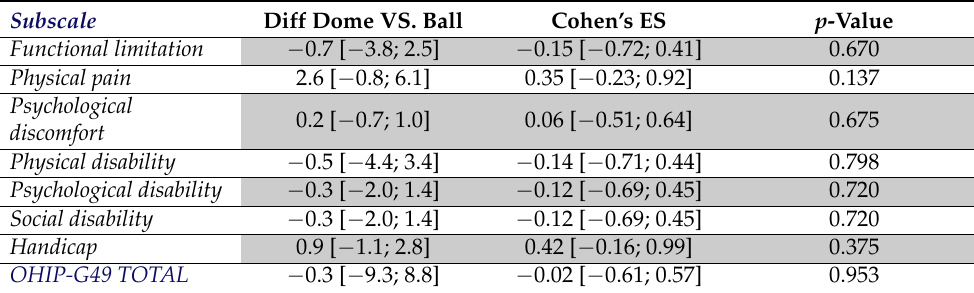
Table 3. Difference and effect size (ES) between the two attachments.